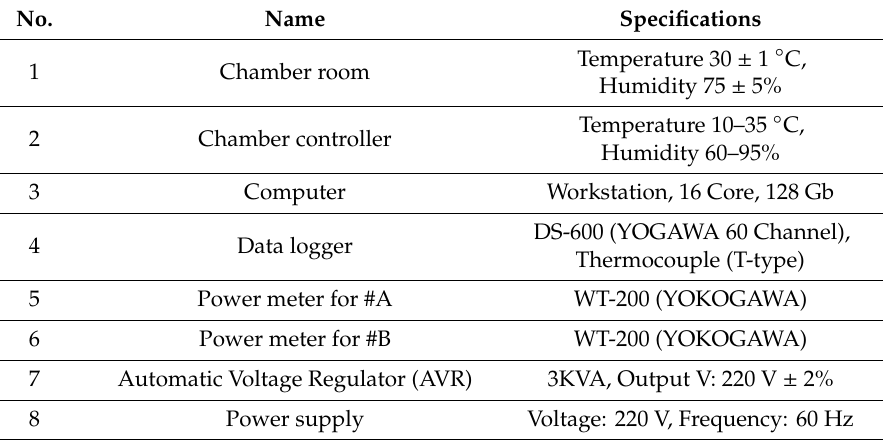
Table 1. Specifications of the apparatus.